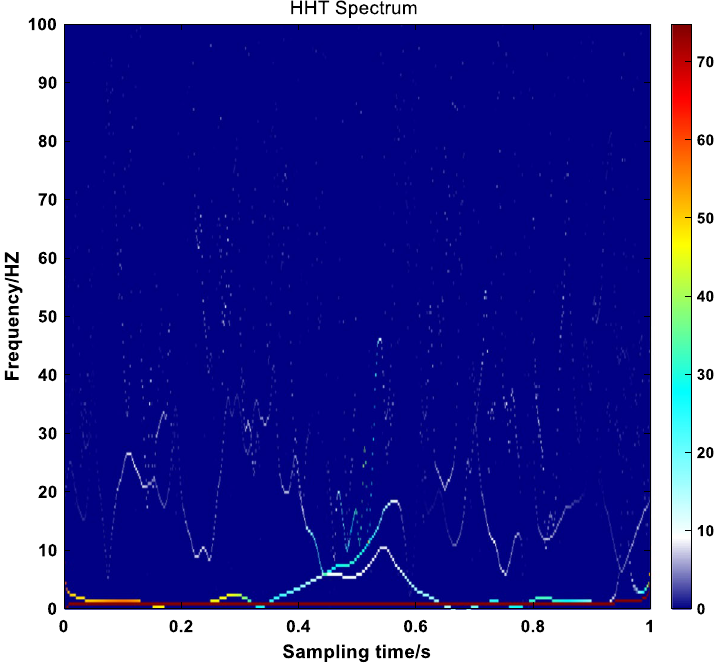
Fig. 8 HHT spectrum local amplification